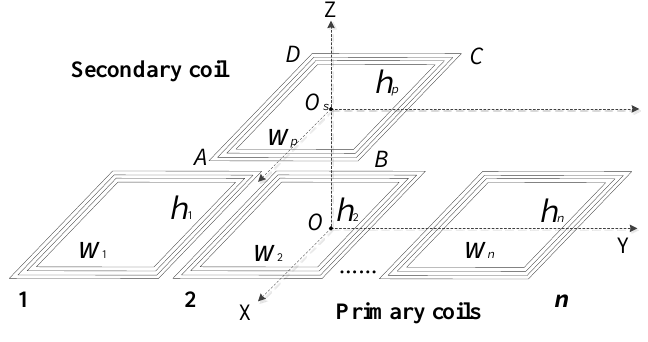
Figure 3. Schematic diagram of coils